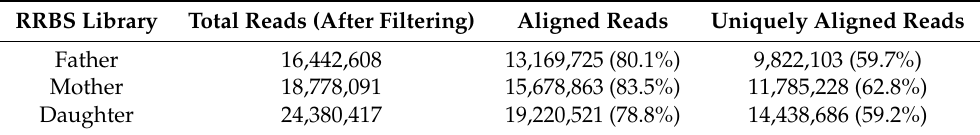
Table 3. Alignment efficiency of reduced representation bisulfite sequencing (RRBS) reads against the human genome (GRCh38 version). Percentages of the aligned reads are in brackets. RRBS